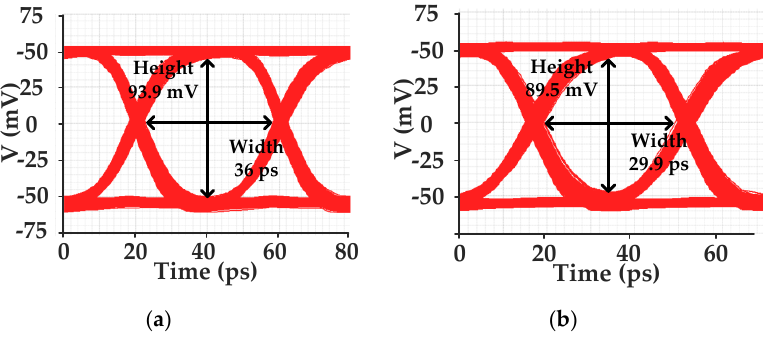
Figure 13. Simulated eye diagrams of the receiver in low-power mode. ( a ) 25 Gb/s; ( b ) 28.9 Gb/s.